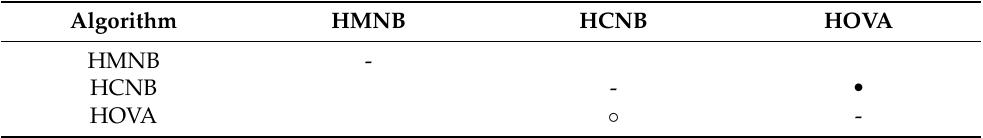
Table 8. Results of the Wilcoxon test for HMNB, HCNB, and